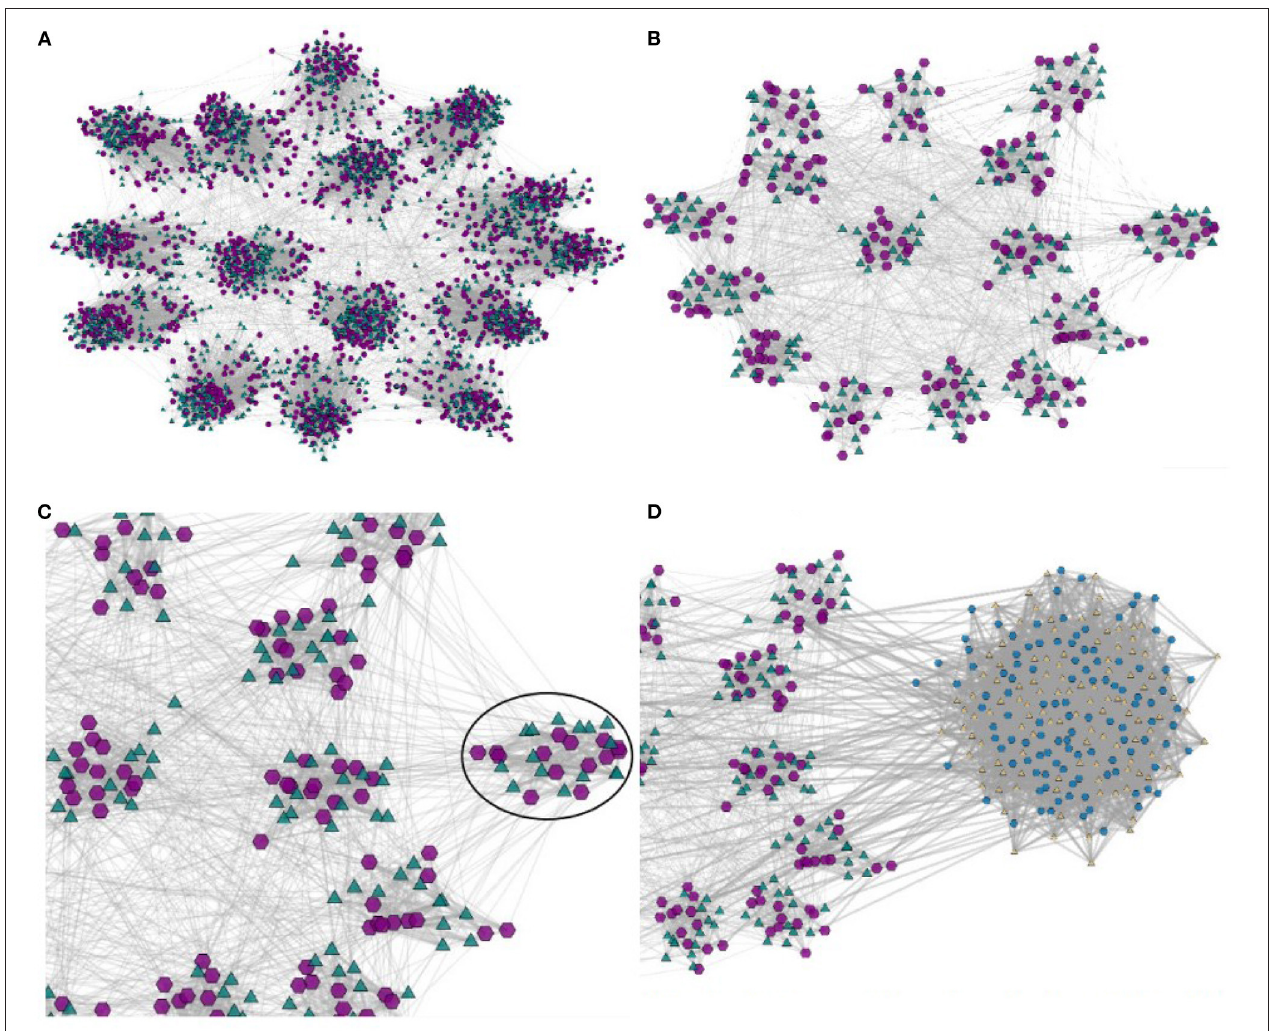
FIGURE 2 | The navigation pathway for exploring a bipartite network made possible by coupling appropriate interaction functions with a hierarchical model obtained applying multilevel coarsening to the original network. The bottom level of the hierarchy corresponds to the full network, the upper level corresponds to its coarsest version, with intermediate networks in between. Compliant with the “visual information seeking mantra” ( Shneiderman, 1996), it displays an initial high-level view of the coarsest network. A user may then expand selected nodes for a more detailed view of the corresponding local structure, which is achieved moving upwards in the hierarchy. S/he may also apply filters and modify the visual mappings of the topological elements, or again drill-down for further detail. S/he may also move downwards in the hierarchy, returning to a coarser view. These and other user operations may be carried out in any sequence. (A) Initial bipartite network. (B) Highest-level view (coarsest network). (C) Selecting a region in the coarsest view. (D) Detailed view of the selected nodes (in the black